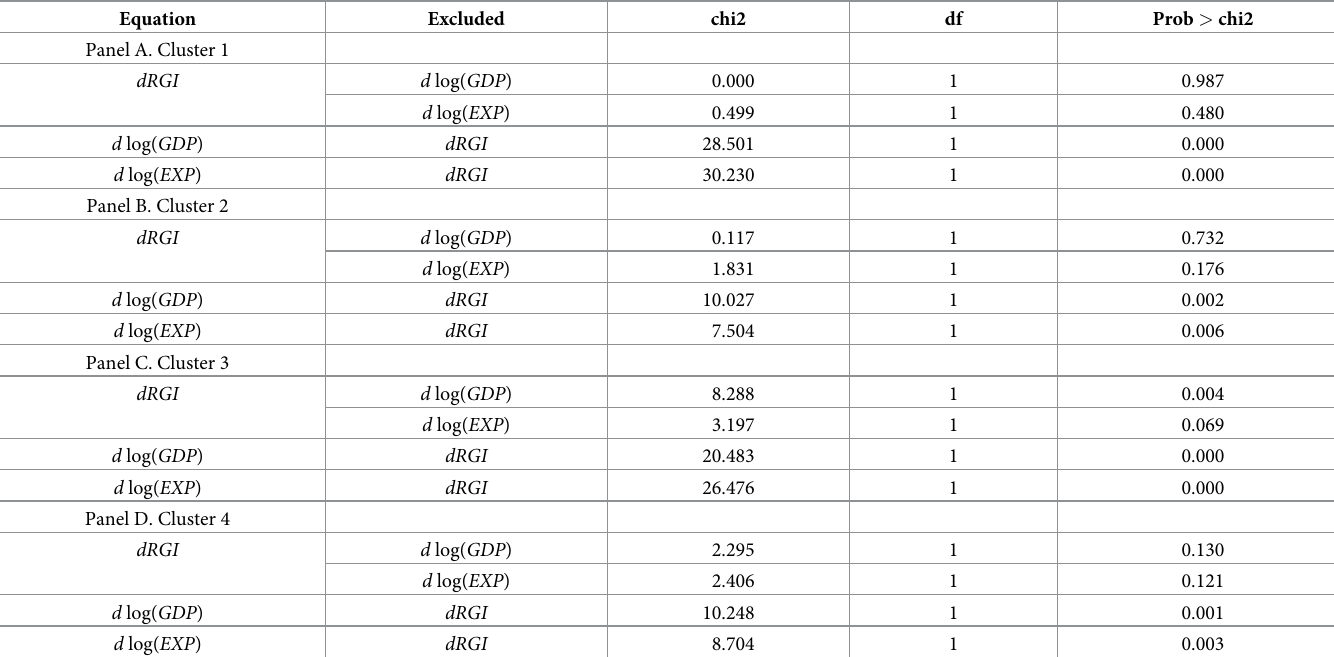
Table 10. Granger causality test results under different country categories (some main results). Equation Panel A. Cluster